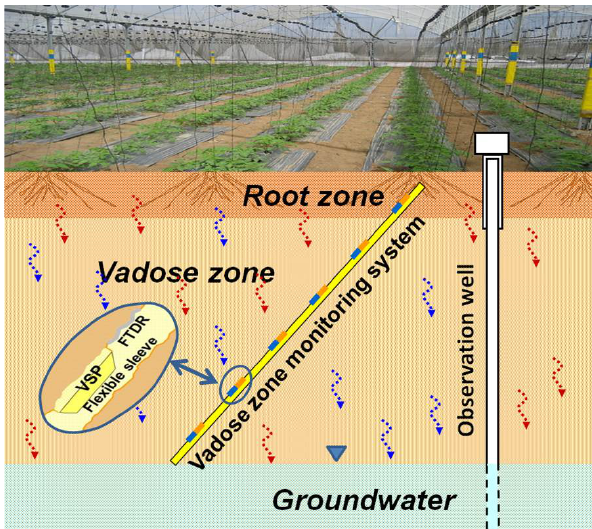
Fig. 1. Schematic illustration of a Vadose zone Monitoring System (VMS) installed under the studied greenhouse. The VMS includes a flexible sleeve hosting multiple monitoring units. The monitoring units are composed of water content sensors (FTDR) and pore water sampling ports (VSP) that are distributed across the entire vadose zone from land surface to